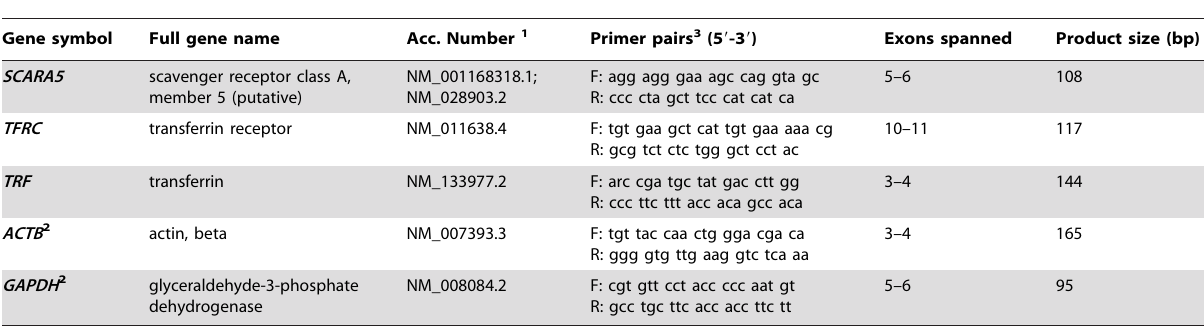
Table 1. Primer pairs sequences for quantitative q-RT- PCR. 1–3